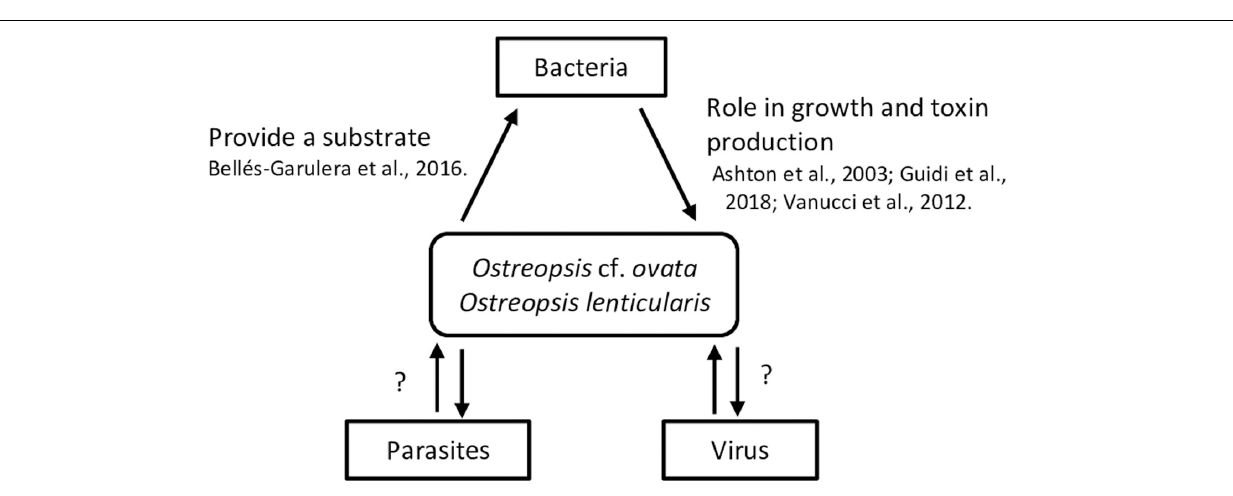
FIGURE 2 | Summary of interactions between Ostreopsis species and virus, bacteria and parasites. Mucus could provide a surface for bacteria; bacterial metabolic activity could both provide N and P to Ostreopsis species and use excreted organic C, N and P from the